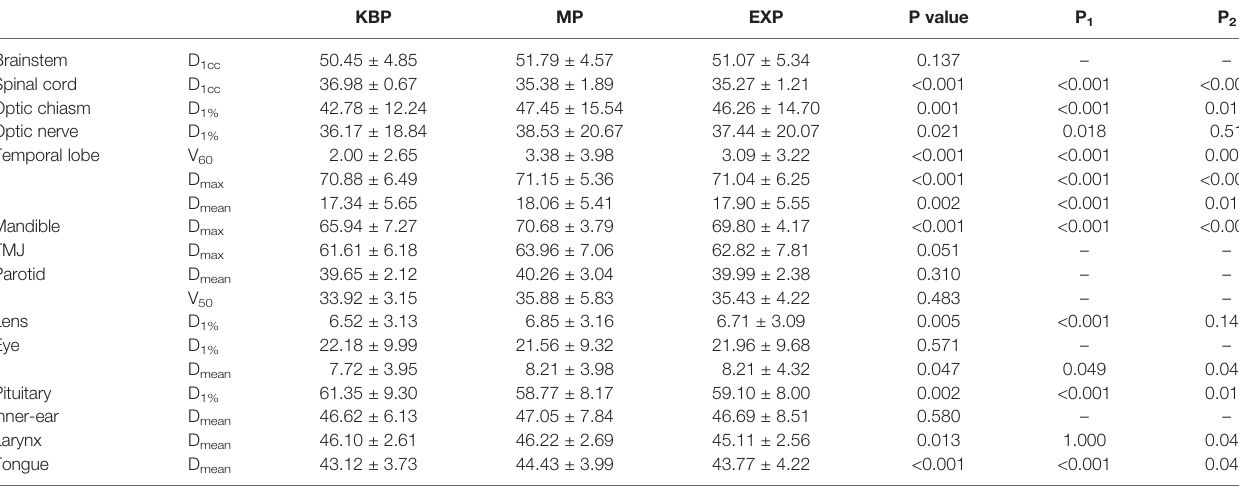
P 1 represents KBP vs MP, P 2 represents KBP vs